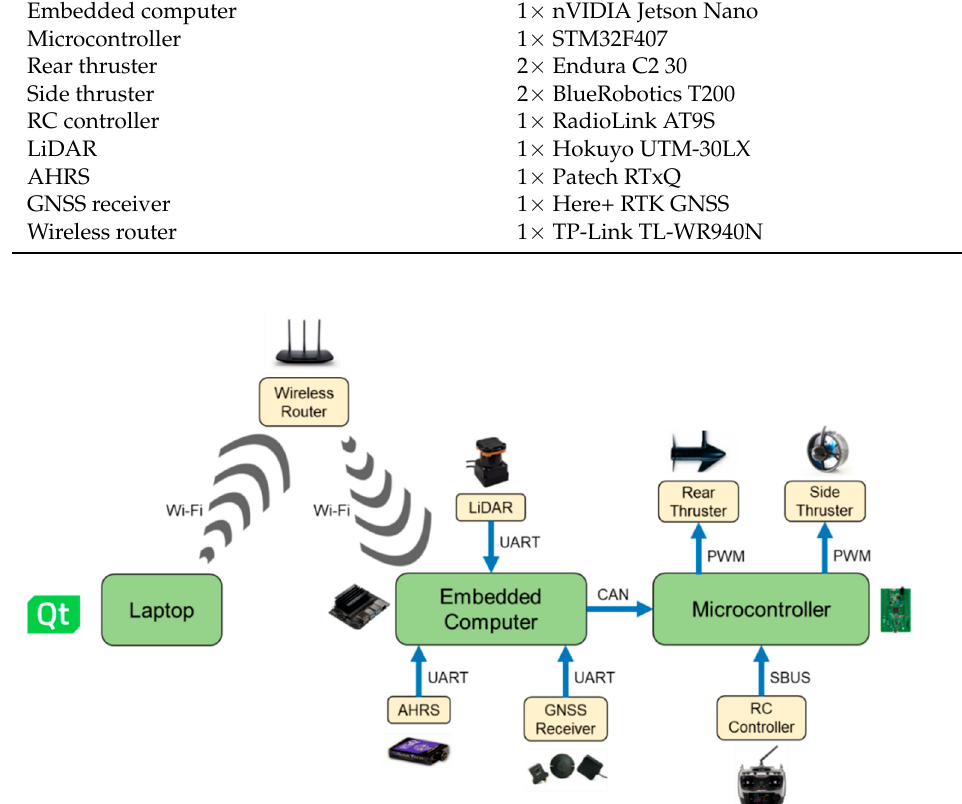
Figure 2. Diagram describing connections between different components of USV2000.